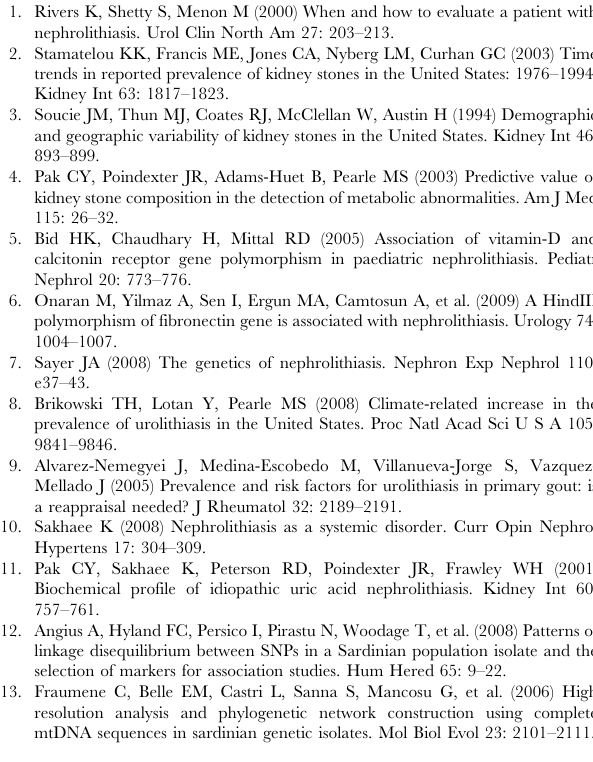
Table S6 Phenotypic characteristics of the case/control sample used in this